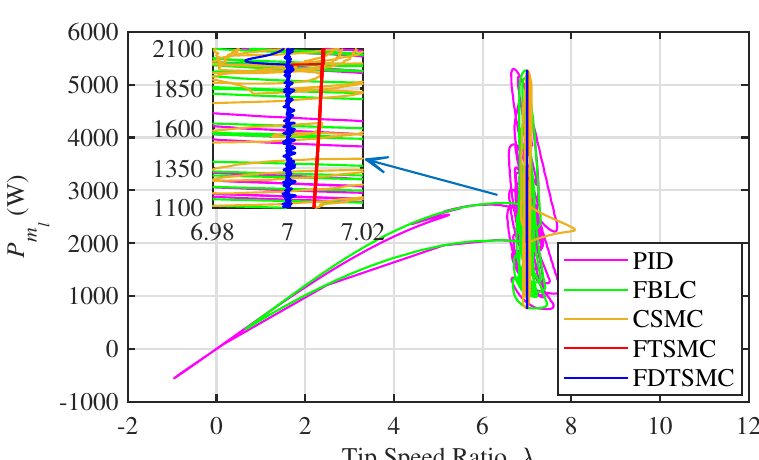
Figure 10. Low-speed shaft mechanical power versus the tip speed